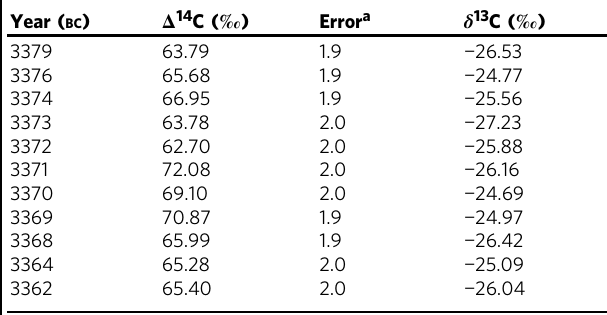
Table 2 Measured results in the Institute of Accelerator Analysis laboratory